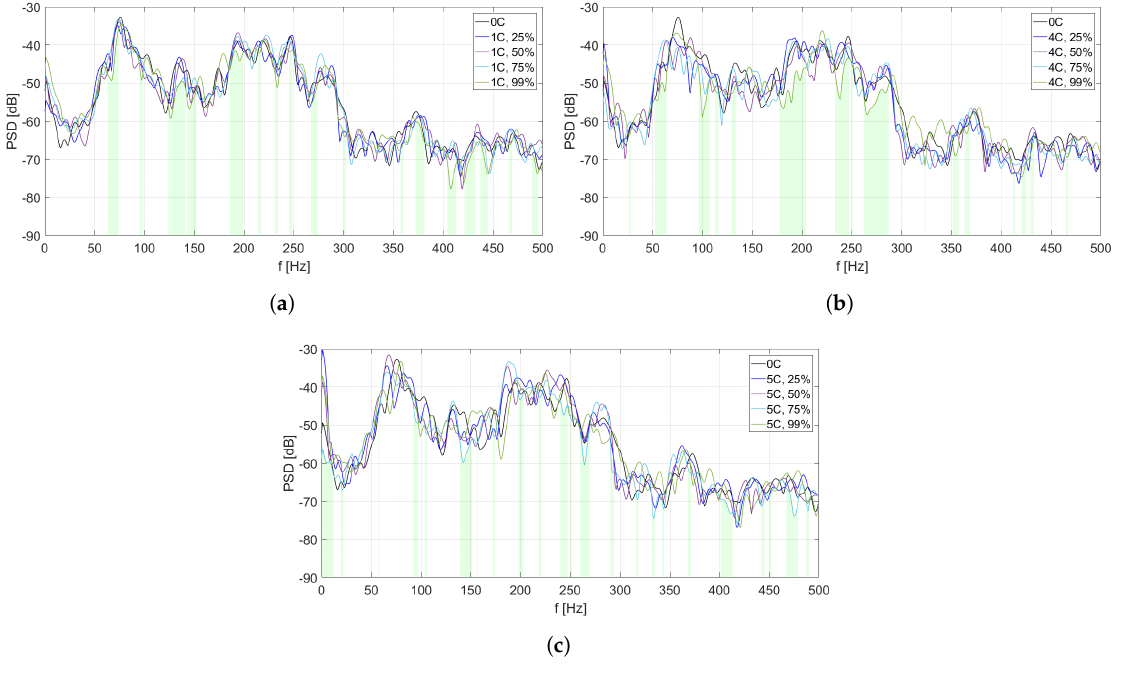
Figure 10. PSD estimates of MFC5 input signals: ( a ) scenario of one coupling activated, ( b ) scenario of four couplings activated, ( c ) scenario of five couplings